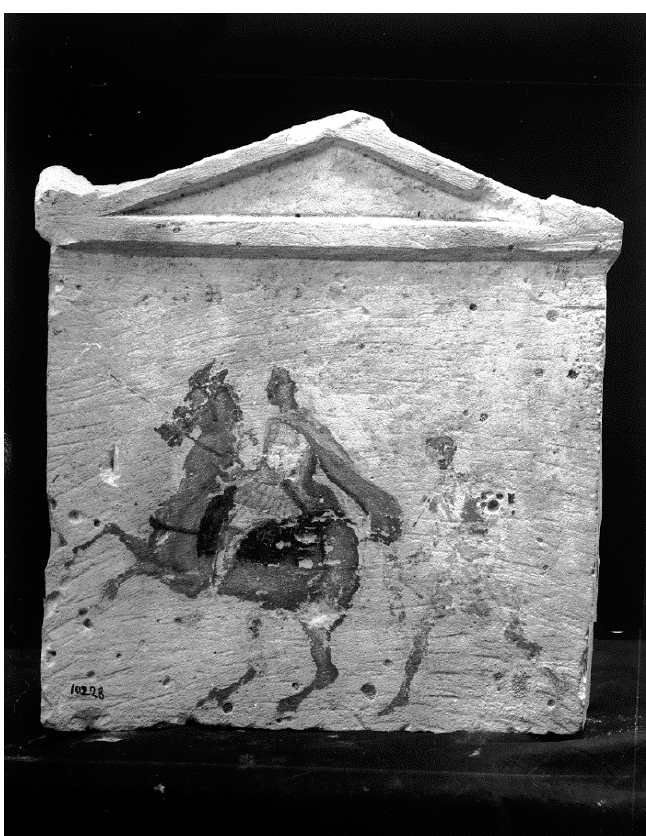
Figure 5. Funerary Stela of a Soldier on Horseback. Photograph courtesy of Kyriakos Savvopoulos.